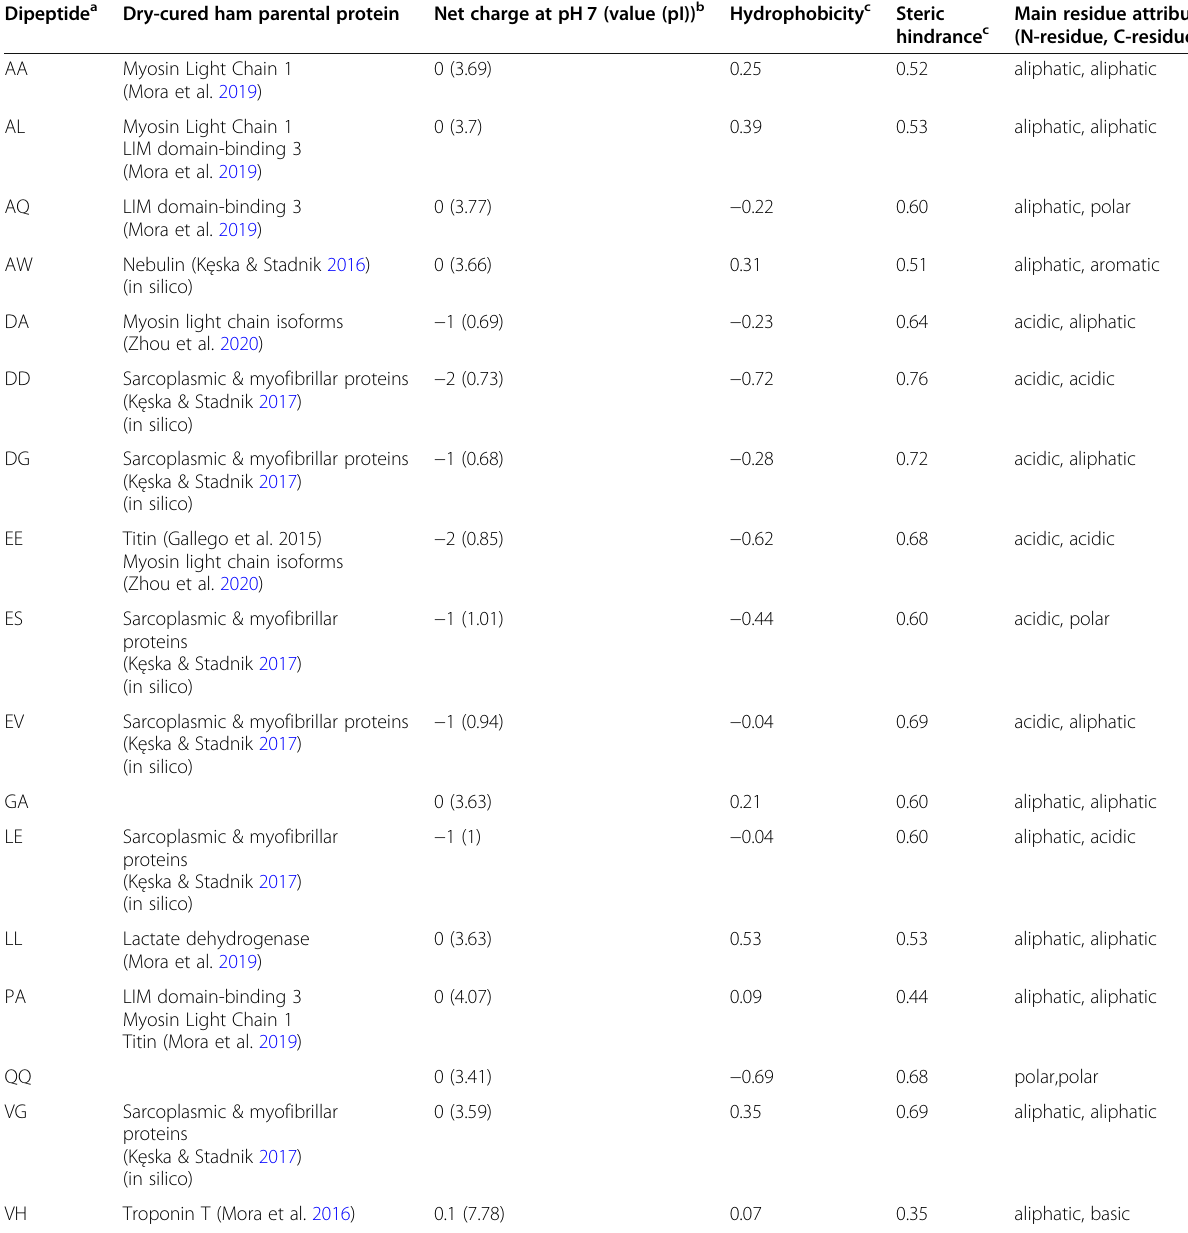
Table 1 Parental proteins and main physicochemical characteristics attributed to the dipeptides of this study Dipeptide a Dry-cured ham parental